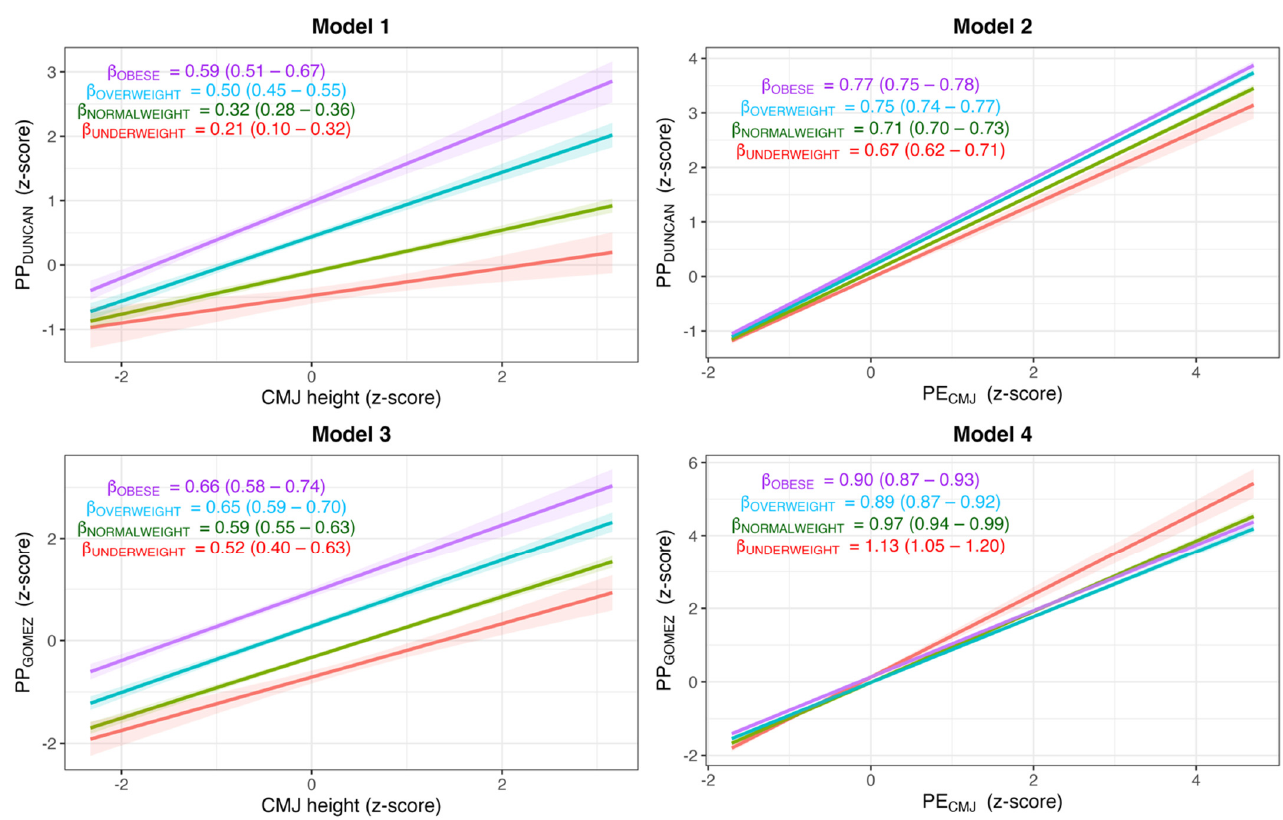
Figure 2. Estimated standardized coefficient (95% credible interval) for each relationship between the outcome (i.e., PP Duncan or PP Gomez ) and the predictor (i.e., CMJ or PE CMJ ) by BMI group. z-scores of PE CMJ were very similar with the z-scores of PP DUNCAN and PP GOMEZ regard- less of the BMI group, in contrast with the z-scores of CMJ height, which followed a dif- ferent trend across the BMI groups than PE CMJ , PP DUNCAN and PP GOMEZ (Figure